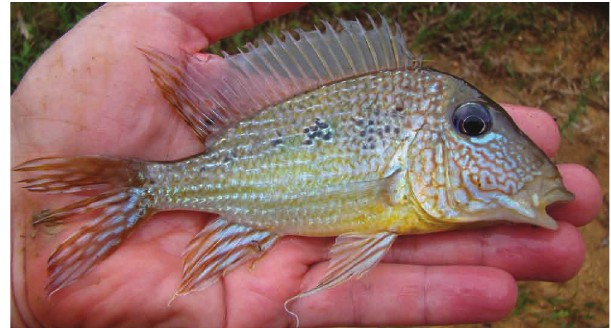
Fig. 2. Geophagus mirabilis , paratype, NUP 15117, 107.8 mm SL, Brazil, State of Mato Grosso, município de Juína, rio Aripuanã, upstream from Dardanelos/Andorinhas falls, immediately after capture. Photograph by Cláudio H. Zawadzki.